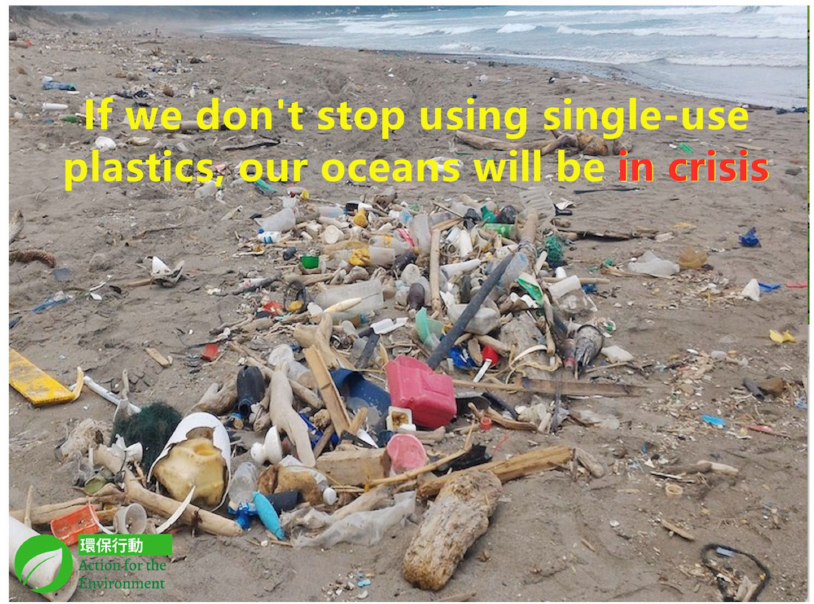
Figure A8. Example of condition 8: Loss * image *